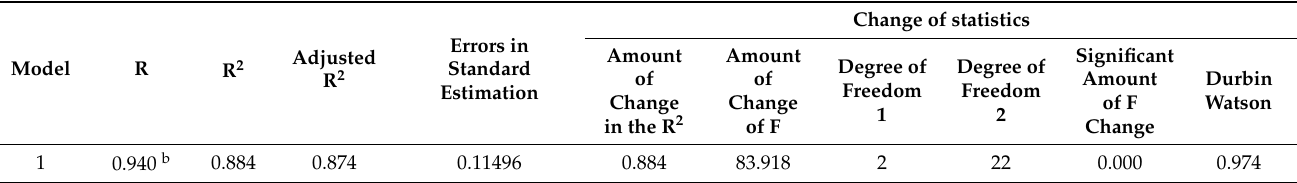
Table 4. Summary of models C